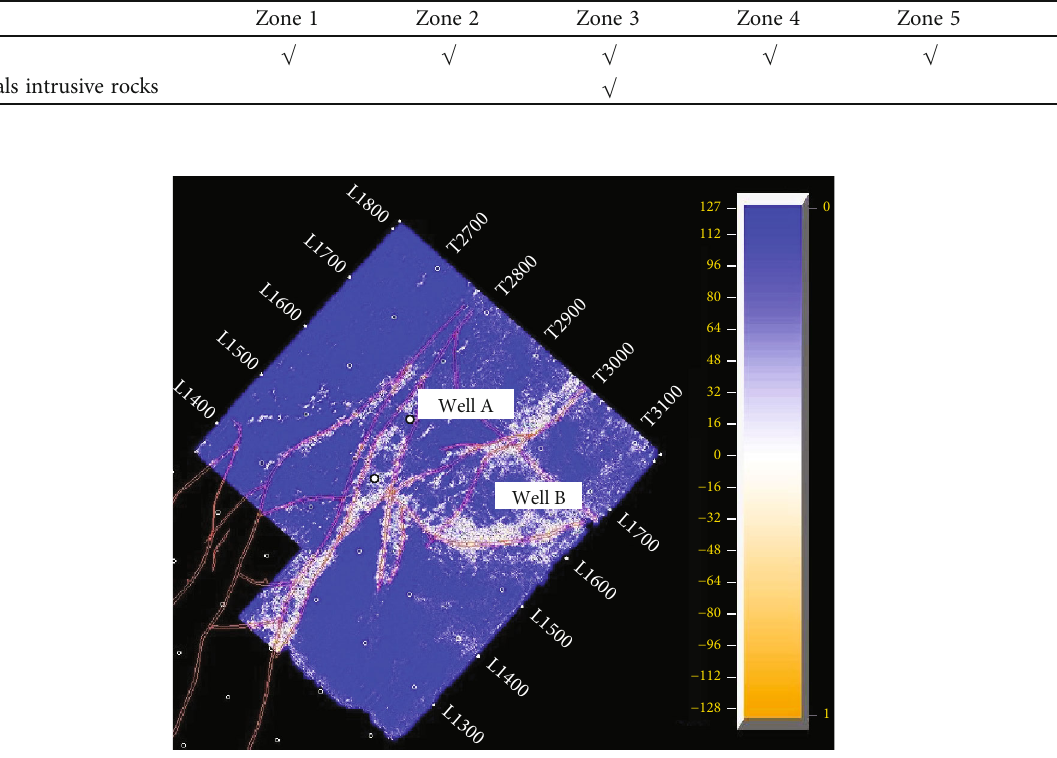
Figure 10: The map of RMS attribute based on di ff raction data.